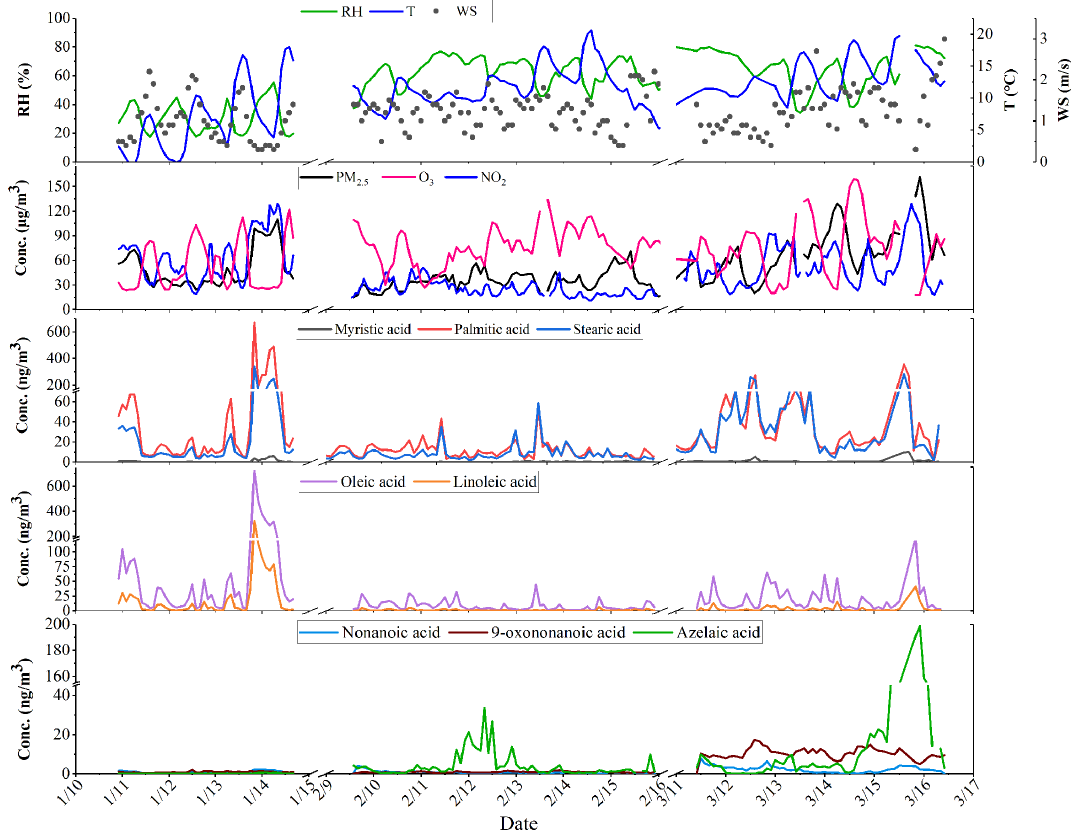
Figure 2. Time series of pollutant concentrations and meteorological parameters.